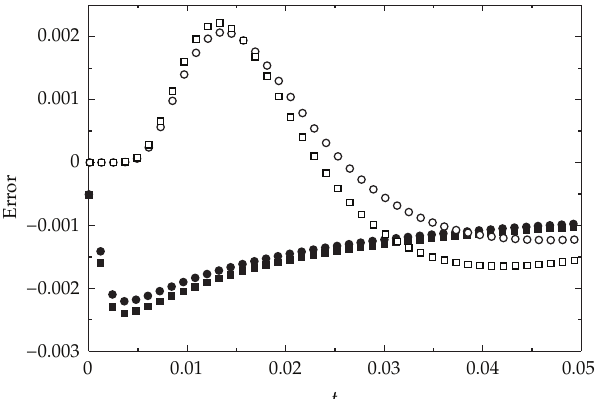
(cid:5) m (cid:6) − u (cid:5) m (cid:6) Figure 4: Error U j j of the numerical method for the problem considered in Figures 1 and 2 at Squares: γ 2 (cid:7) 1; circles: γ 2 (cid:7) 1 / 2; hollow symbols: γ 1 (cid:7) 1; filled symbols: γ 1 (cid:7) 1 /